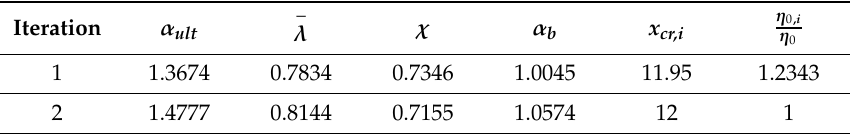
Table 3. Example 3: key values for each iteration.